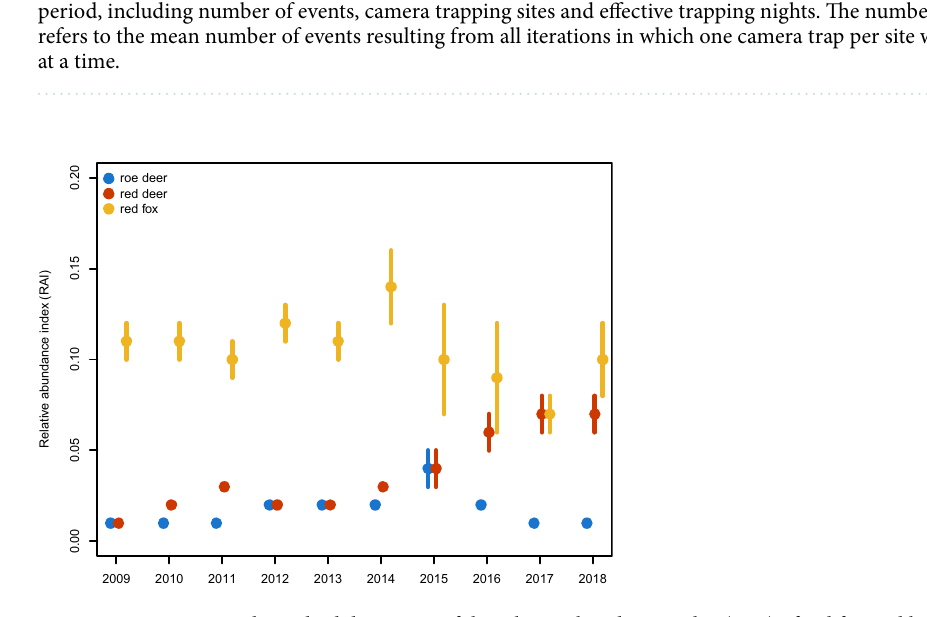
Figure 3. Estimates and standard deviations of the relative abundance index (RAI) of red fox and lynx’s prey species roe deer and red deer calculated for the BFNP